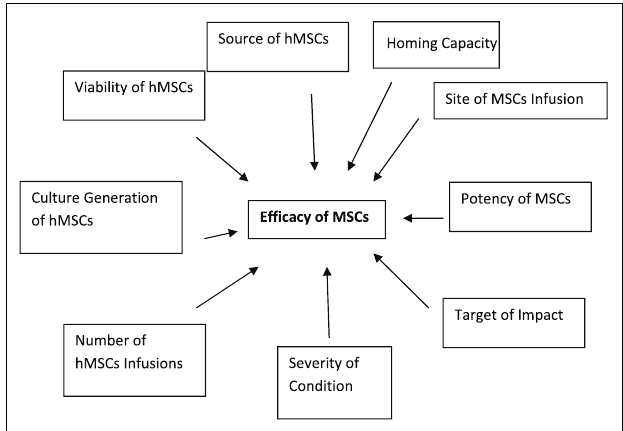
FIGURE 1 |The dynamic definition of MSC efficacy . Efficacy or the biological impact of MSC on biological processes is dependent on a variety of parameter. As outlined in the schematic below the variability in efficacy is dependent not only on the source and quality of the MSCs themselves but also on the response of the recipient to the administration of MSCs.This is a dynamic and continuous process that can ultimately be defined by the potency of the MSCs in the context of disease, model, and outcome